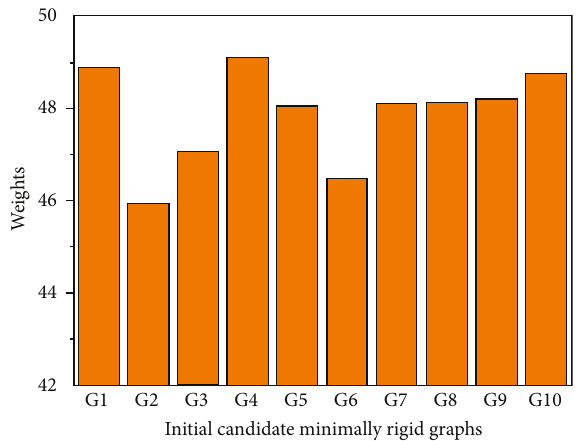
Figure 20: The weights of the initial candidate minimally rigid graphs. G2 is the min-weighted rigid graph at initial.